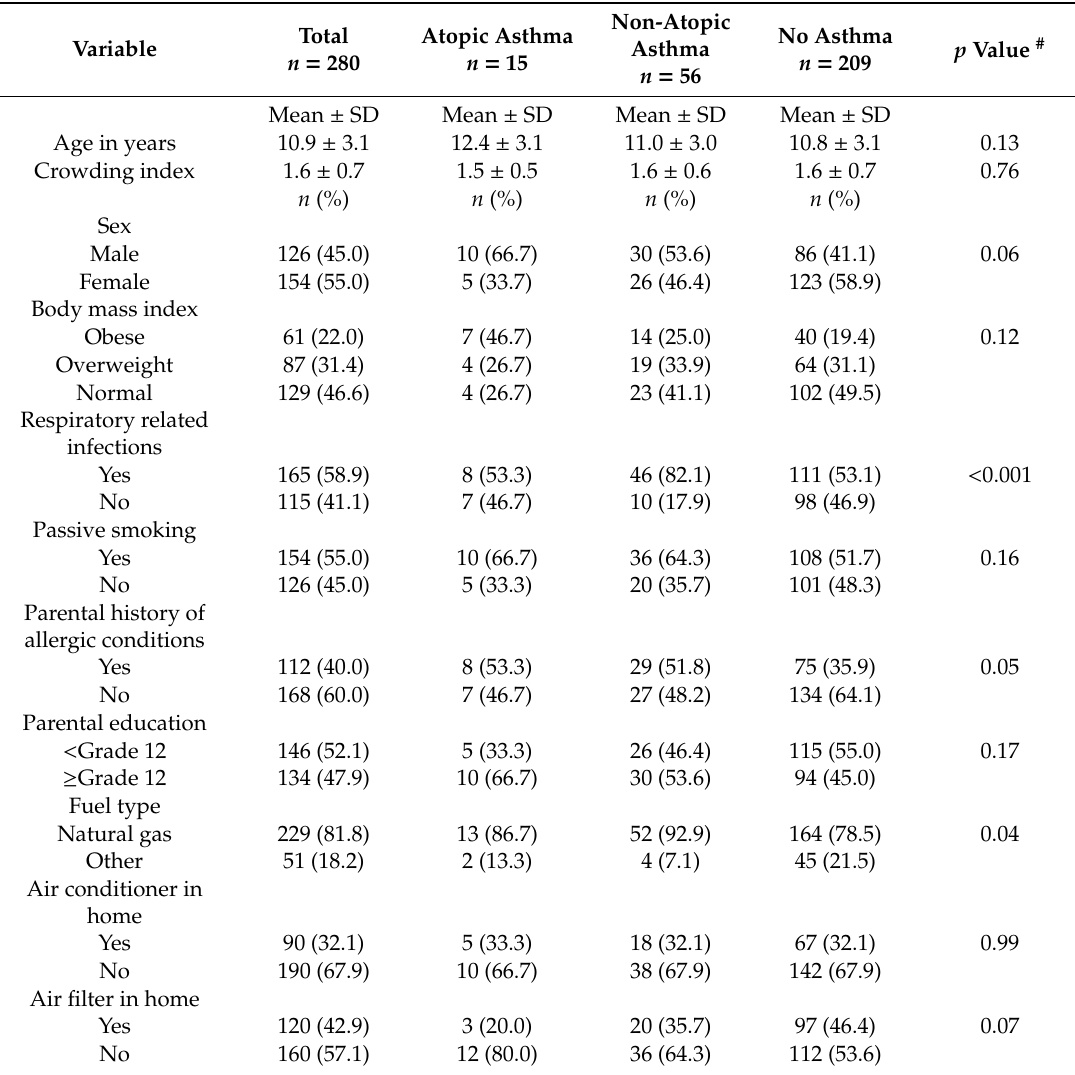
Table 1. Personal and housing characteristics by asthma phenotype for 280 First Nation